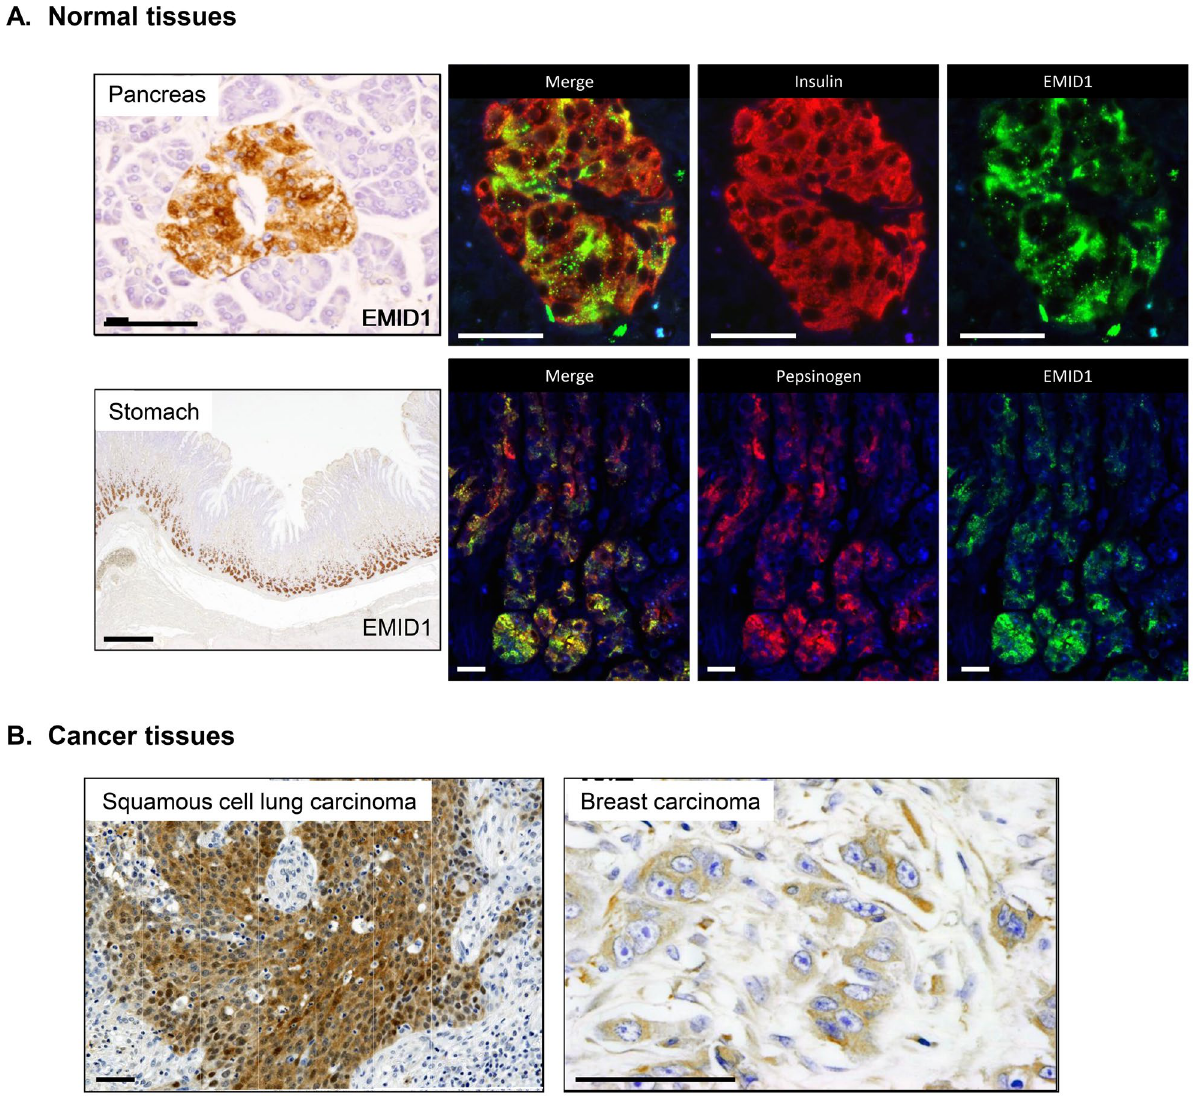
Figure 5. Expression of EMID1 protein in normal and cancer tissues. ( A ) EMID1 expression in human normal tissues. Immunohistochemistry and immunofluorescence show restricted expression of Emid1 protein in a pancreas islet (upper panel) and gastric fundic gland (lower panel). Scale bars indicate 50 μm and 500 μm, respectively. Emid1 (green) colocalized with insulin (red) in the pancreas and pepsinogen (red) in the stomach. Scale bar, 20 μm. ( B ) EMID1 expression in human cancer tissues. Representative immunohistochemical images of EMID1 protein expression in squamous cell lung carcinoma (left) and breast carcinoma (right). Scale bar, 50